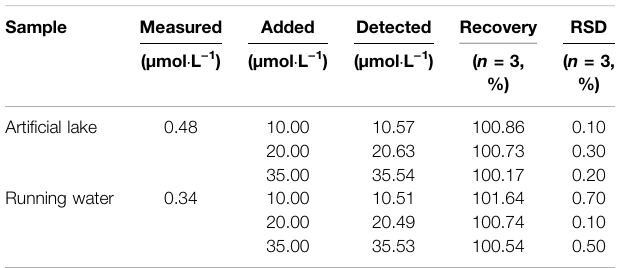
TABLE 2 | Detailed data for CN − detection in real water